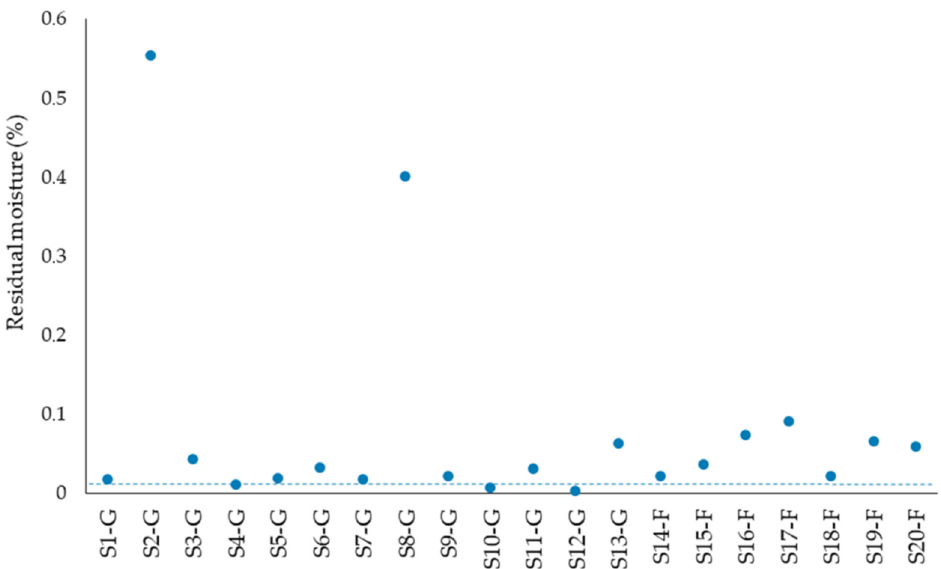
Figure 2. Residual moisture of rPET samples. The dotted line specifies literature value for the residual moisture.